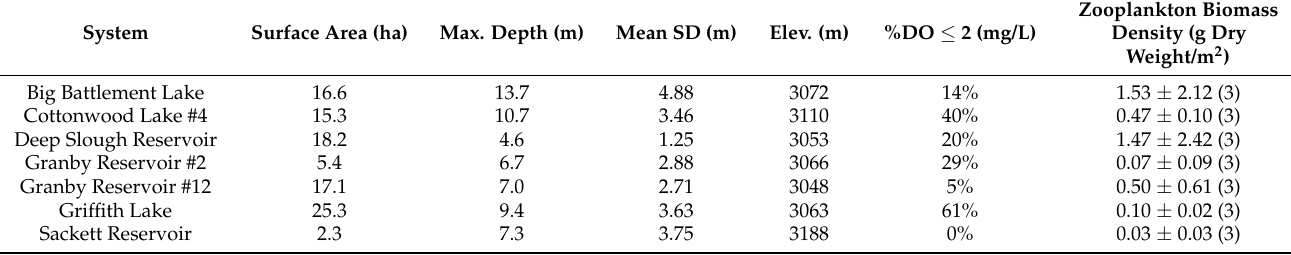
Table 1. Characteristics of the study systems including surface area (ha), maximum depth (m), mean summer Secchi disk depth (SD; m), elevation (Elev.; m), percent (%) of water column with dissolved oxygen (DO) levels ≤ 2 mg/L, and the summer biomass density (g dry weight/m 2 ) of zooplankton (mean ± SD)—an indicator of system productivity (number of individual zooplankton tows listed in